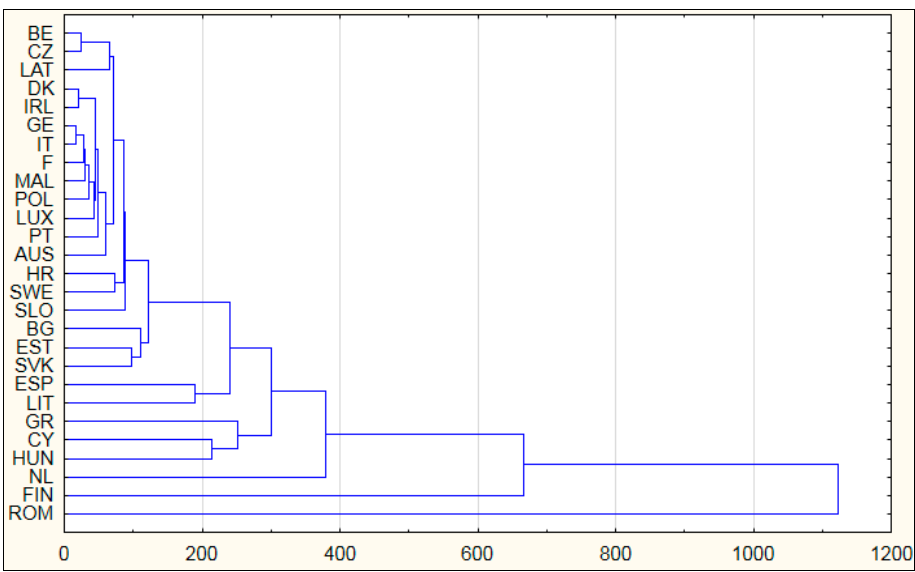
Figure 5. Cluster analysis.